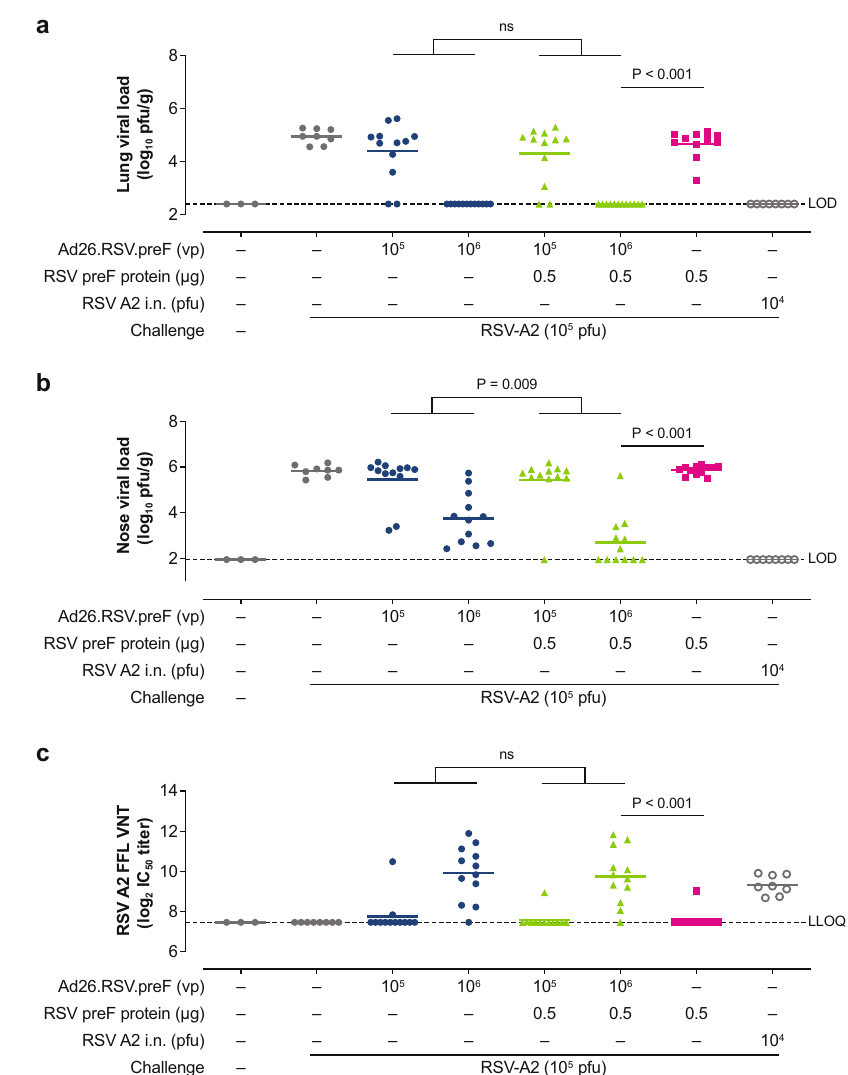
Fig. 4 Immunogenicity and protective ef fi cacy in cotton rats. Naïve female cotton rats were immunized intramuscularly at Week 0 with Ad26.RSV.preF (1 × 10 5 or 1 × 10 6 vp; n = 12 in each group), RSV preF protein (0.5 µg; n = 12), or Ad26.RSV.preF (1 × 10 5 or 1 × 10 6 vp) combined with RSV preF protein (0.5 µg; n = 13 in each group). Negative control groups received phosphate-buffered saline ( n = 3 and n = 8, assay control and challenge control, respectively) and the positive control group received i.n. RSV A2 (1 × 10 4 pfu; n = 8). Cotton rats were challenged i.n. with RSV A2 (1 × 10 5 pfu) at Day 49 and Day 54. Viral load was measured in lung ( a ) and nose homogenates ( b ) and expressed as log 10 pfu/g tissue. Horizontal lines indicate the mean viral load per group, and the dotted line indicates the LOD. RSV A2 VNT, expressed as log 2 IC 50 , were measured in prechallenge serum samples obtained at Day 49 ( c ). Horizontal lines indicate mean VNT per group, and the dotted line indicates the LLOQ. Statistical comparisons between groups receiving Ad26.RSV.preF alone versus those receiving Ad26.RSV.preF/RSV preF protein combinations were made using a Cochran – Mantel – Haenszel test based on rank scores with the Ad26.RSV.preF dose as the strati fi cation variable. Comparisons between animals receiving Ad26.RSV.preF/RSV preF protein combinations versus those receiving RSV preF protein alone were made using a Wilcoxon rank sum test with Bonferroni correction. Tests were conducted at an overall signi fi cance level of α = 0.05. Ad26, adenovirus type 26; FFL, fi re fl y luciferase; IC50, half-maximum inhibitory concentration; i.n., intranasally; LLOQ, lower limit of quanti fi cation; LOD, limit of detection; ns, not signi fi cant; pfu, plaque-forming units; preF, prefusion conformation-stabilized RSV F protein; RSV, respiratory syncytial virus; VNT, virus neutralization titers; vp, viral (comparing Week 60 and Week 61 using a paired t test; tested prior to boost immunization at Week 60. Although animals P ≤ 0.035 for all; Fig. 5a). RSV preF protein alone also induced a receiving RSV preF protein (150 µg) alone showed similar peak boost response of 17-fold; however, this response did not reach responses, VNT were signi fi cantly lower compared with the statistical signi fi cance ( P = 0.061, paired t test) due to the low Ad26.RSV.preF groups after Week 4, suggesting reduced durability number of animals ( n = 4) and high variation in this group. Prior to of the response in this group. boost immunization, RSV preF protein showed signi fi cantly lower AGMs immunized with Ad26.RSV.preF and the combination VNT compared with Ad26.RSV.preF alone and the Ad26.RSV.preF vaccine showed robust VNT responses that were stable up to (1 × 10 11 vp)/RSV preF protein (150 µg) combination ( P < 0.001 and Week 60. Homologous boost immunization at Week 60 induced a signi fi cant boost response in groups receiving Ad26.RSV.preF P = 0.019, respectively, ANOVA for potentially censored values alone and Ad26.RSV.preF/RSV preF protein combinations with Dunnet correction for multiple comparisons); this difference